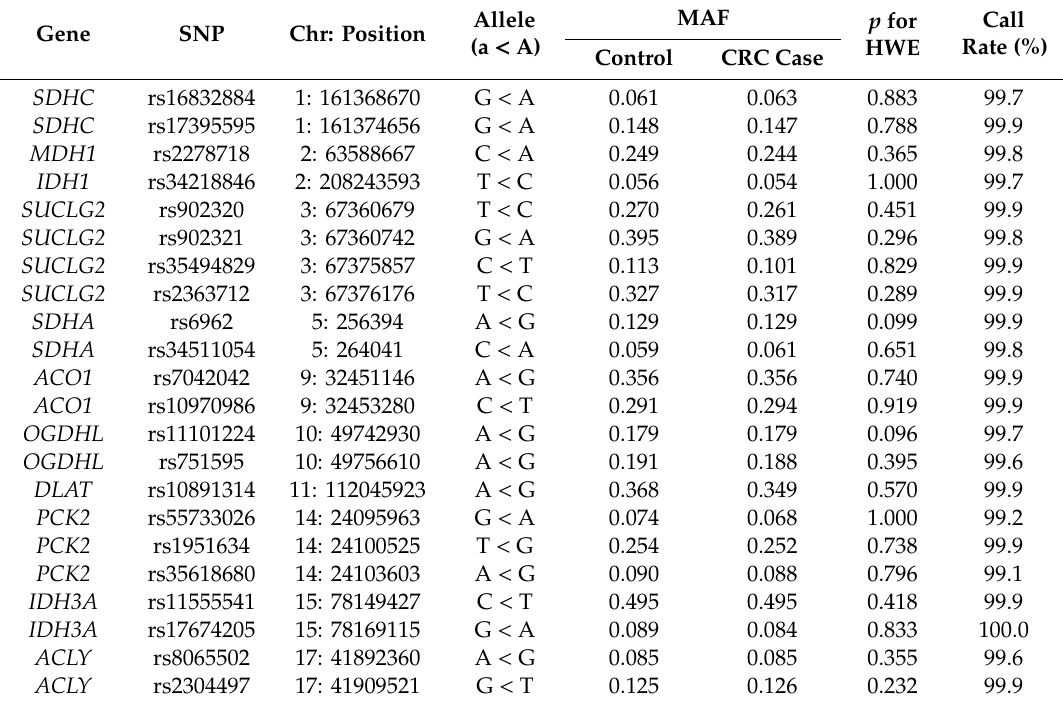
Table 1. Information on SNPs that were included in the present